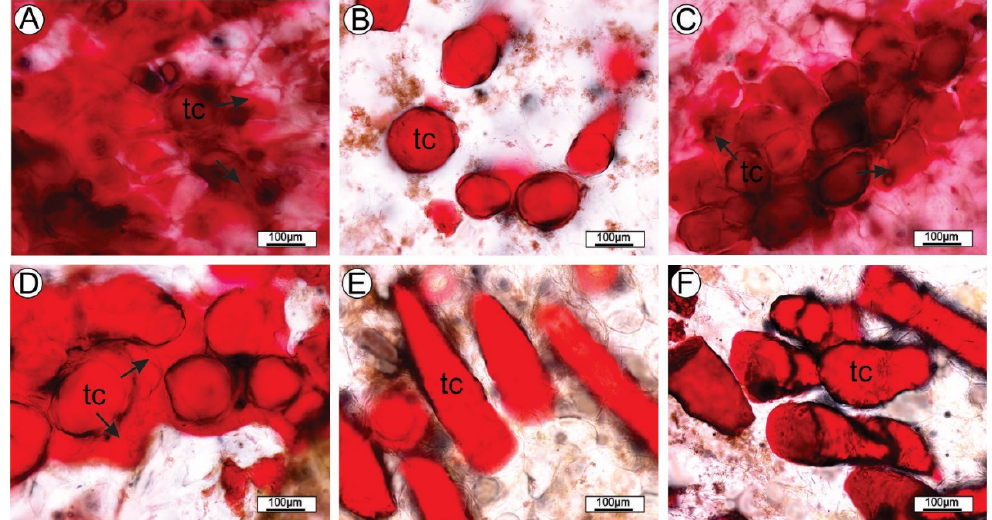
Figure 2. Tissue sections of ‘Giombo’ persimmon flesh. ( A ) Harvest, ( B ) 1 day after CO 2 treatment, ( C ) 1 day after ethanol treatment, ( D ) Ethanol-treated fruit after 15 d at 1 °C + 5 d at 20 °C, ( E ) Ethanol-treated fruit after 25 d at 1 °C + 5 d at 20 °C; ( F ) Ethanol-treated fruit after 40 d at 1 °C + 5 d at 20 °C. Cells with extravasated tannin content ( A , C , D ), tannins accumulate near tannic cells ( B ) and tannic cells intact dispersedly in the degraded parenchyma ( E , F ). tc: tannic cell.